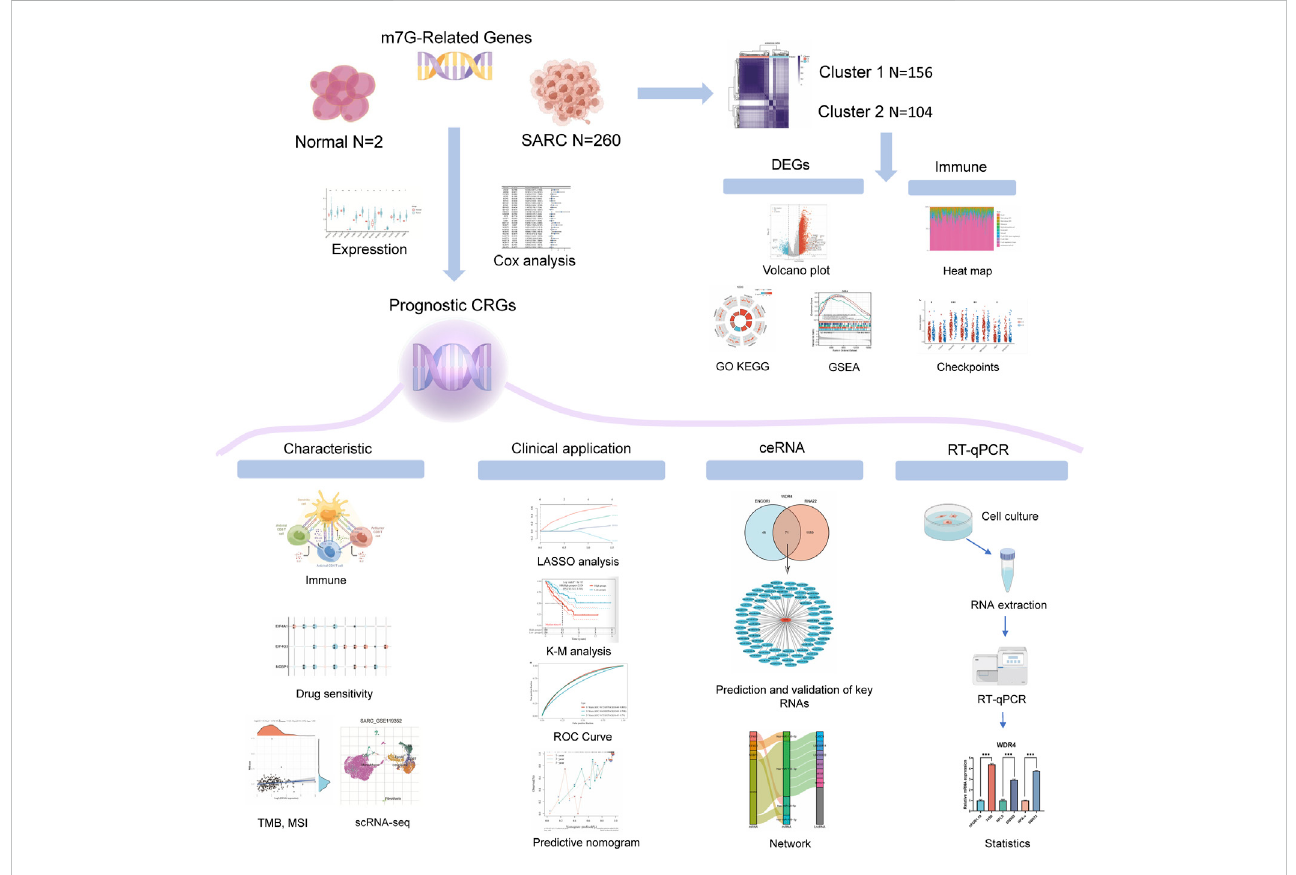
FIGURE 1 The fl owchart of the present